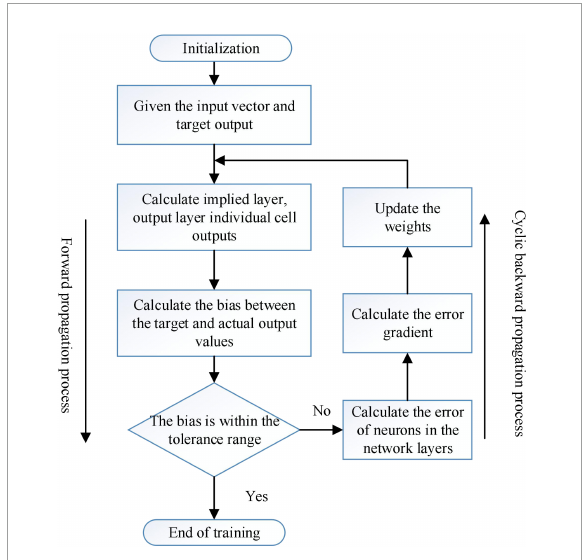
FIGURE8 Improved training flowchart of convolution neural network.